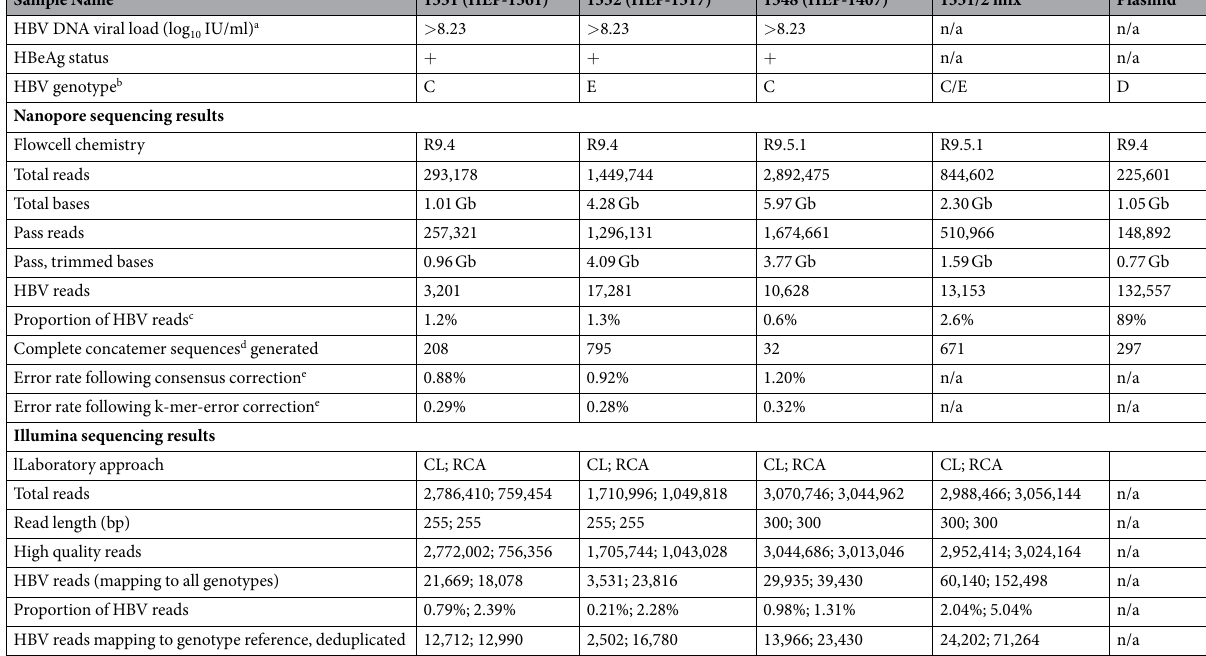
Table 1. Details of samples used for HBV sequencing. Patients were adults with chronic HBV infection, enrolled through a cohort in Oxford, UK. HBV = hepatitis B virus, HBeAg = hepatitis B e-antigen, n/a = not applicable, CL = completion ligation, RCA = rolling circle amplification. Note that the yields and pass rates of these runs varied. They were conducted on different flowcells and a different basecaller version was used. As it stands, this assay is not quantitative, and we anticipate that yields of high-quality HBV reads will continue to vary as the Nanopore technology develops. a Upper limit of quantification for HBV DNA viral load is 8.23 log 10 . b Genotypes determined by read mapping to genotype consensus sequences derived from HBVdb sequences. c The proportion of reads mapped to HBV out of the total number of pass reads d Defined as concatemers with ≥ 3 full genome reads, with all genome reads mapping to either the plus or minus strand (see methods). e Based on comparison with Illumina sequence and calculated at sites with < 1% variation in Illumina